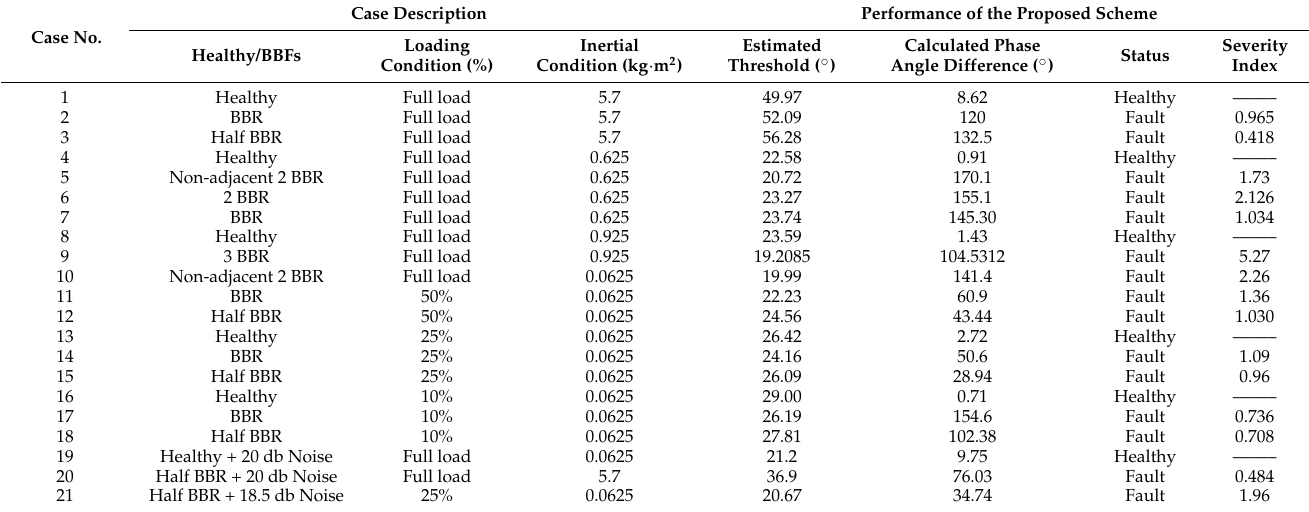
Table 2. Testing the proposed scheme on Motor I.